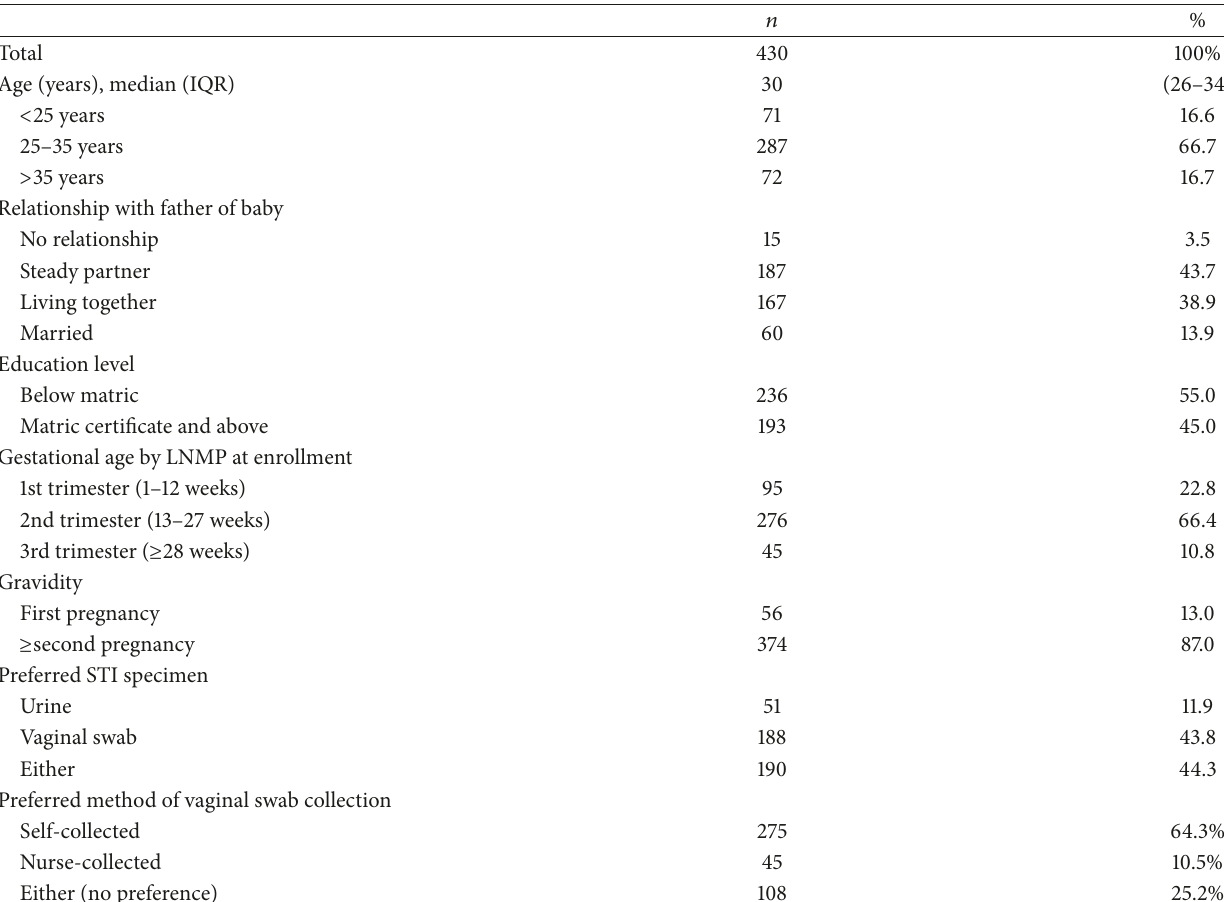
Table1:Characteristicsofthehumanimmunodeficiencyvirus-infectedpregnantwomenenrolledintheantenatalscreeningstudyinTshwane